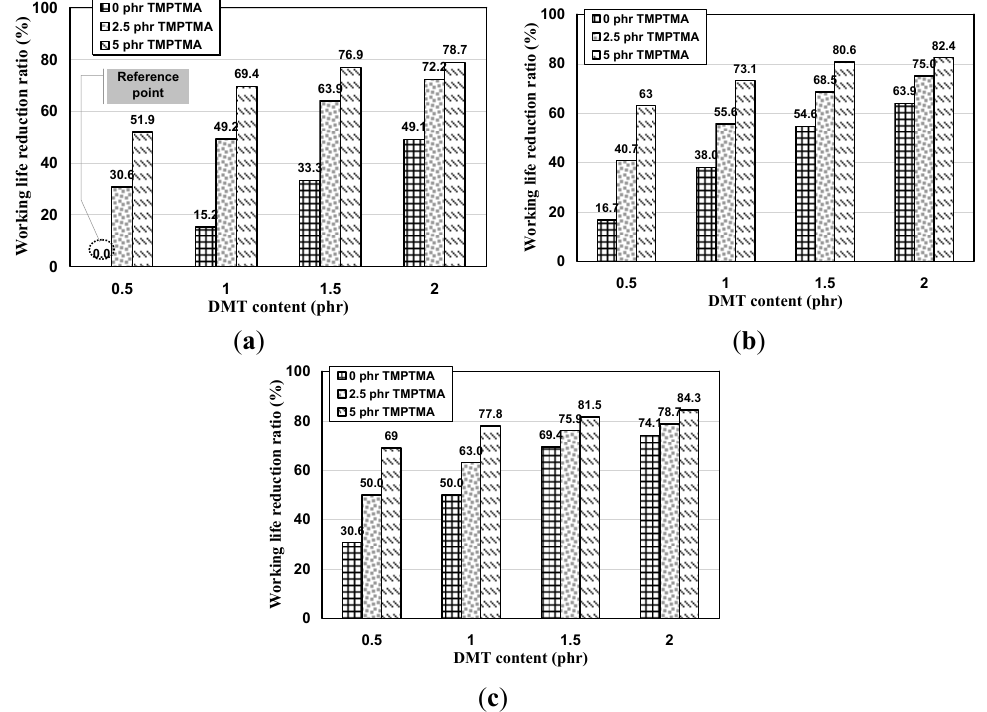
Figure 5. Effects of DMT and TMPTMA contents on the working life reduction ratio of acrylic polymer concrete cured at different temperatures. ( a ) − 20 °C; ( b ) − 10 °C; and ( c ) 0 °C.